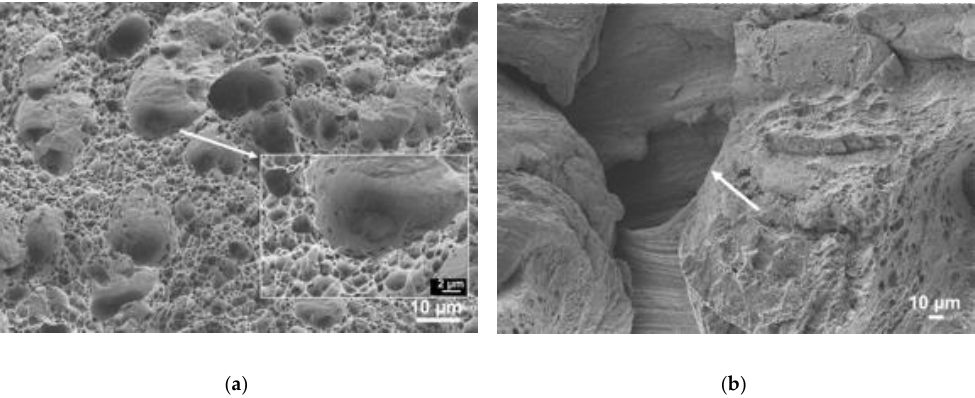
( b ) Figure 13. Strain distribution in tensile test specimens close to failure from the ( a ) 562-30 and ( b ) 562- 120 series. Figure 14 illustrates the influence of the welding speed on the fracture surface morphology of test pieces from series 562-30 and 562-280 performed at speeds of 30 and 280 mm/min, respectively.